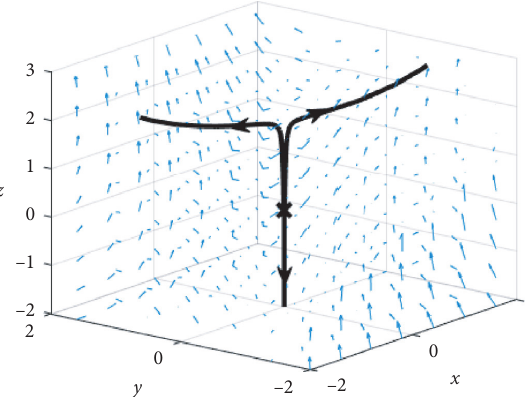
Figure 6: Stability of control parameters under the second Lyapunov exponent.